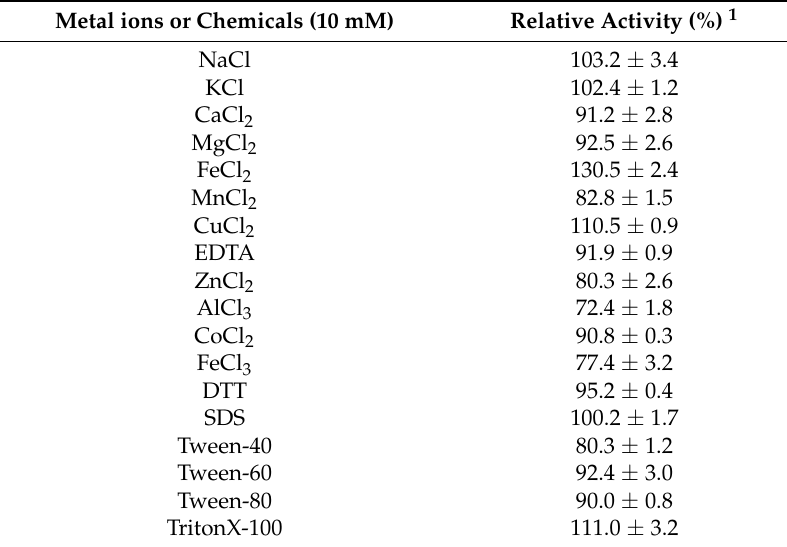
Table 3. Effect of various metal ions and chemicals on the activity of Pp Abf51b.